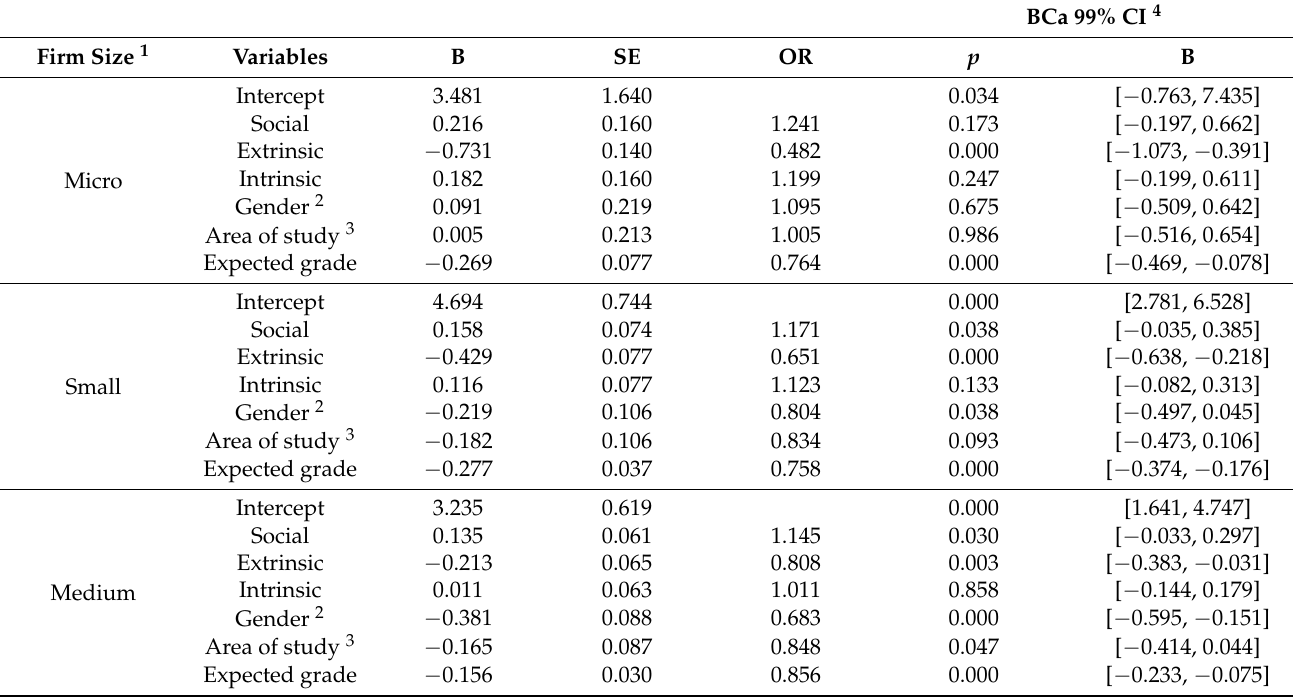
Table 5. Multinomial logistic regression for preferred employer